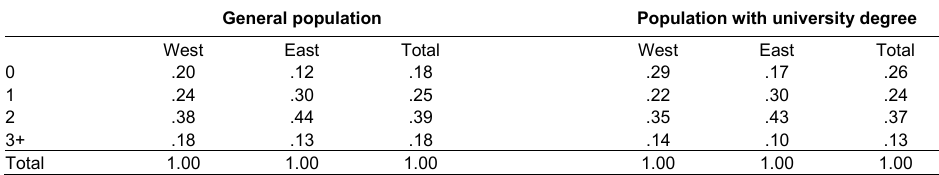
Table 3 : Distribution of the female reference population by number of children, educa- tion level, and region. Column fractions displayed. Data source: Own calcula- tion based on the 2012